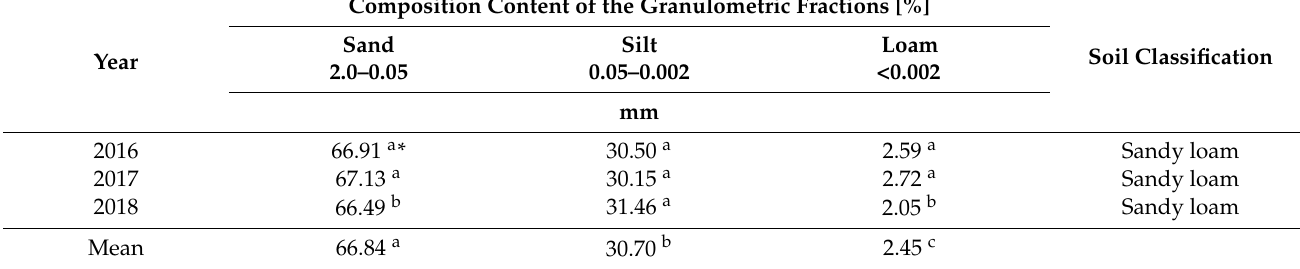
Table 5. The granulometric composition of